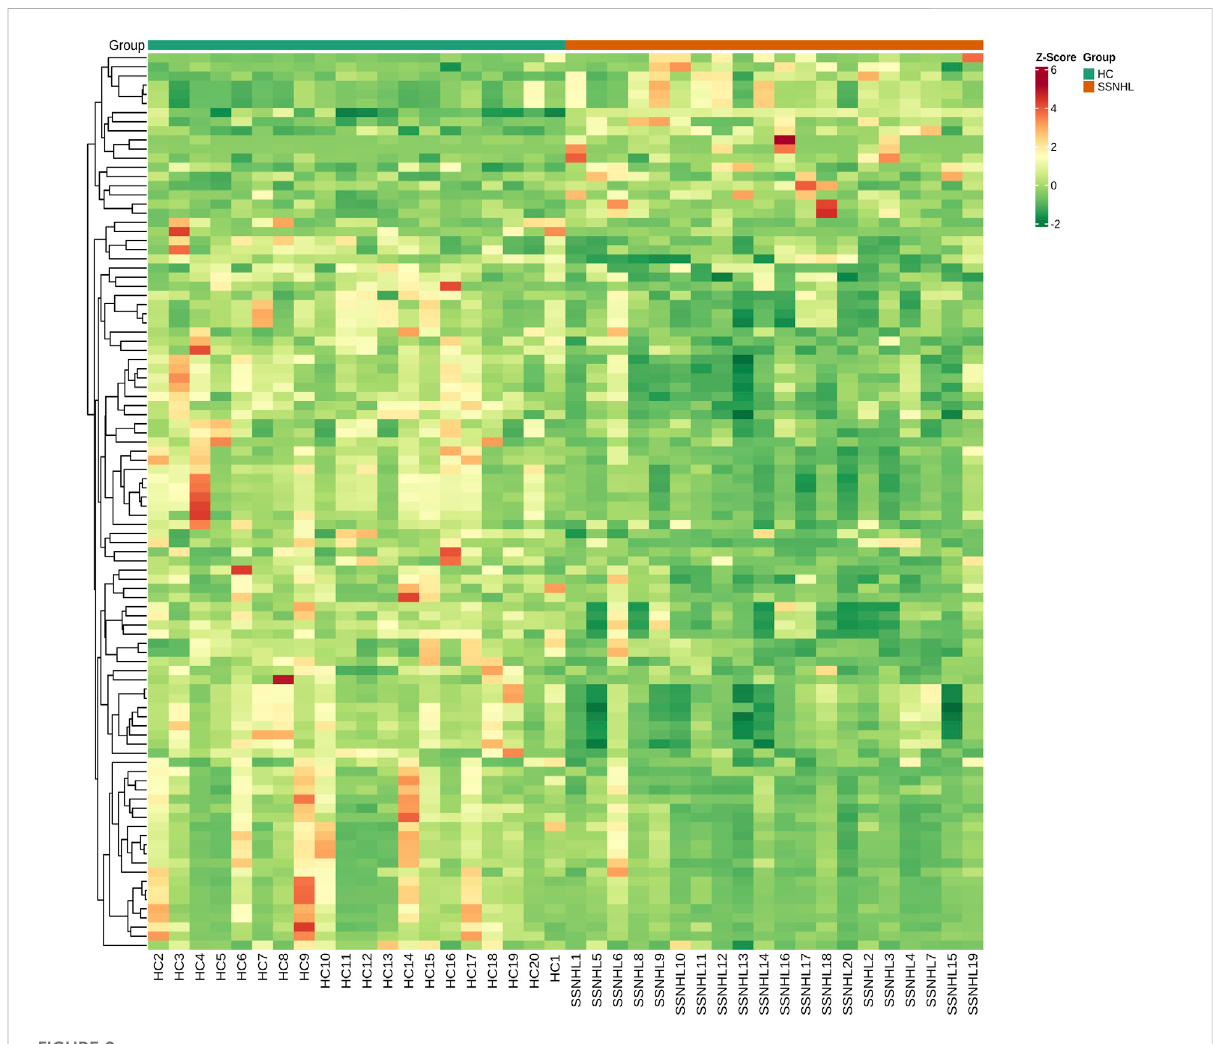
FIGURE 2 Heat map of the 98 discriminative metabolites between SSNHL group and HC group. SSNHL, sudden sensorineural hearing loss; HC, healthy